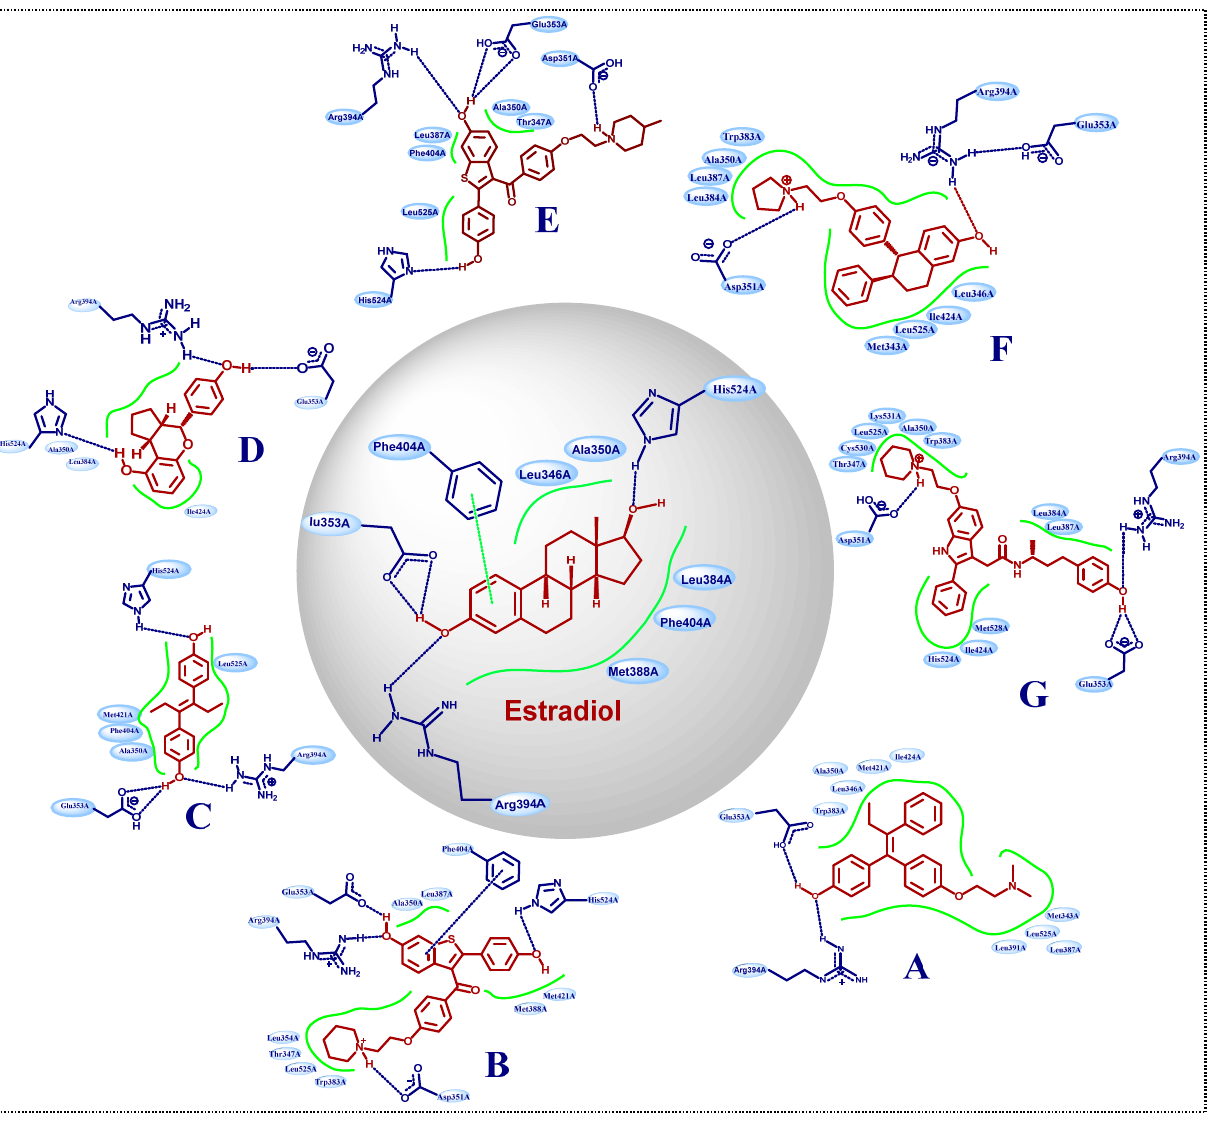
Figure 4. The interactions of ligands with ER- α receptor: Estradiol (PDB Id: 1GWR), ( A ) Tamoxifen, ( B ) Raloxifen, ( C ) Diethylstilbestrol, ( D ) Hexahydrocyclopenta[e]chromene, ( E ) Benzothiazine, ( F ) Naphthalen, and ( G ) Indole.